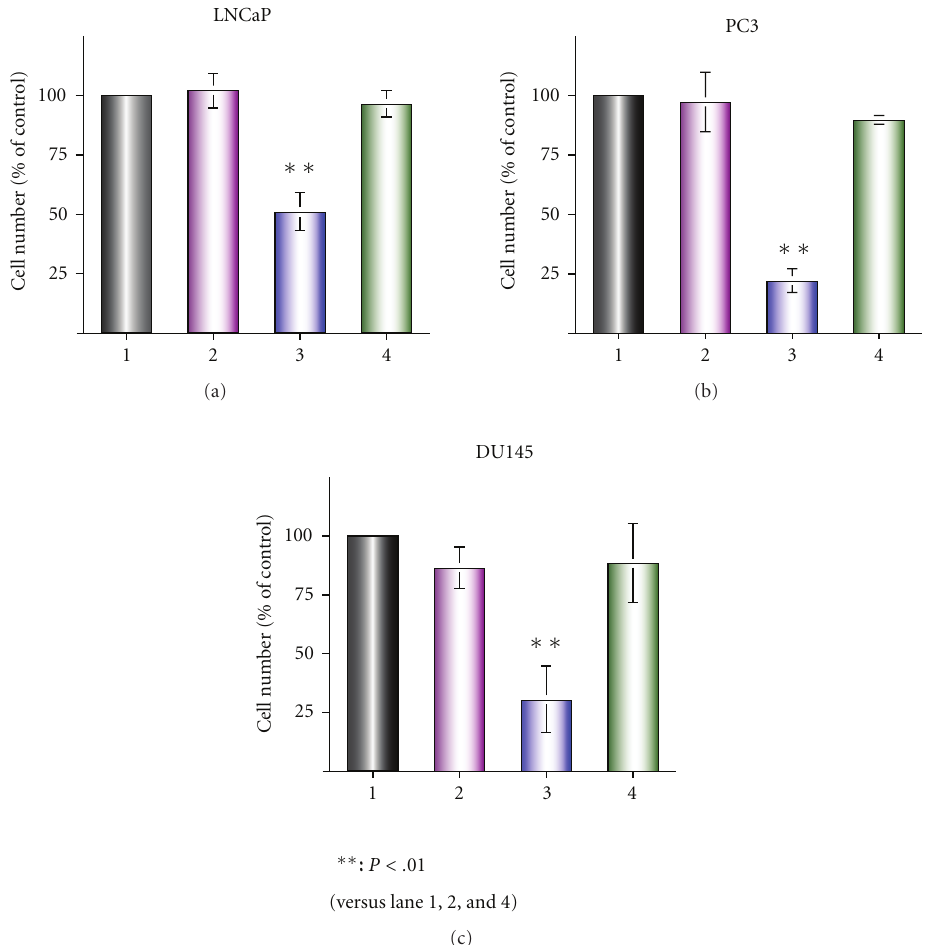
Figure 2: GGOH restored the growth inhibition induced by Zol. Cells were incubated in 2 × 10 − 5 M of Zol in combination with 30 μ M of GGOH for 72 h. The cell number counted in the vehicle control was defined as being equal to 100. Lane 1: control, lane 2: GGOH, lane 3: Zol, and lane 4: Zol + GGOH.